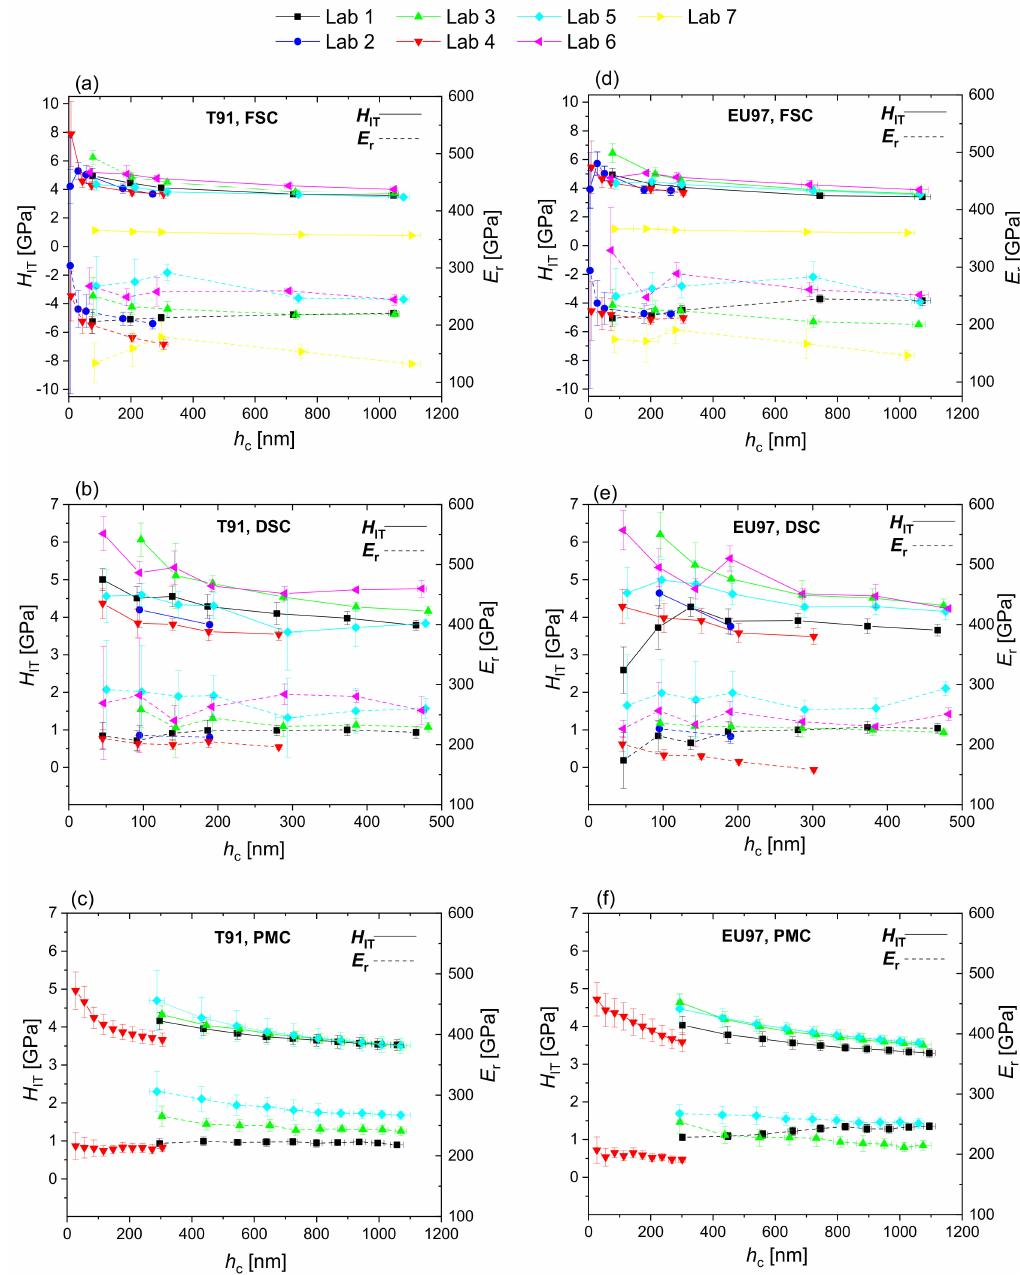
Figure 2. Indentation hardness, H IT , and reduced modulus, E r , of T91 ( a – c ) and Eurofer97 ( d – f ) measured by single cycles in force control (FSC), single cycles in depth control (DSC) and multicycles in force control (PMC) at di ff erent